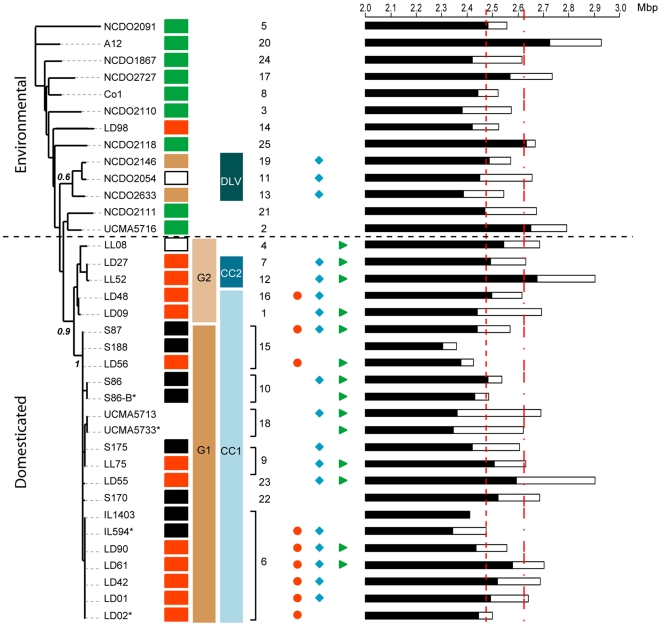
Comparison of gene-based phylogeny, strain origins, and genome properties.The genome features (chromosome/plasmid content size, presence of genes of industrial importance) of the 36 L. lactis subsp. lactis strains are compared to MLST-based strain relatedness. From left-to-right: neighbor-joining tree of the 36 strains, strain name; strain origin (color code: green  =  plant, brown  =  animal skin, white  =  milk, red  =  starter strains, black  =  cheese, unmarked  =  uncertain origin); genetic groups determined from the NJ tree; clonal complexes determined by eBURST; ST numbering; presence of citP gene (red dot), lacE gene (blue diamond), and prtP gene (green triangle); chromosome (black rectangles) and plasmid content (white rectangles) sizes. Derivative strains are indicated by an asterisk. The two dashed red lines indicate mean chromosome and genome size, respectively.